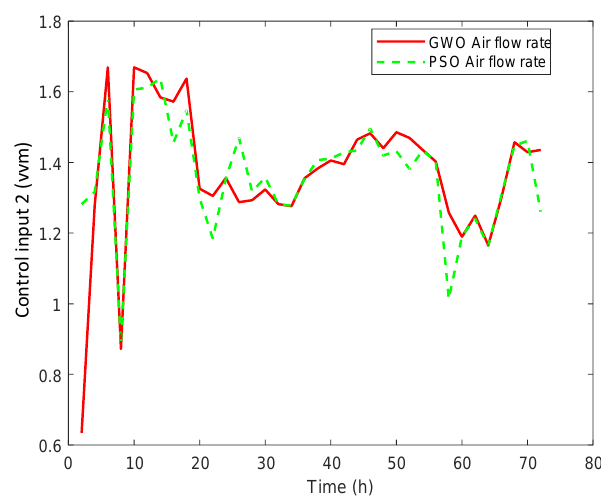
Figure 9. GWO-NMPC controlled airflow rate u 2 with optimal reference.